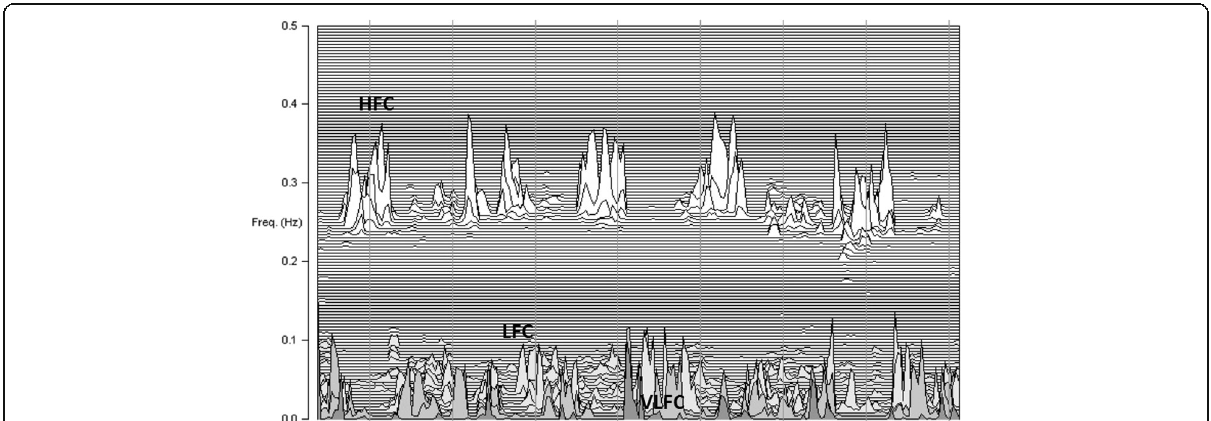
Fig. 2 Sample ECG-spectrogram. Note high, low and very low frequency coupling (HFC, LFC and VLFC respectively) and the clear separation in signal space of HFC from LFC/VLFC. HFC is the ECG-spectrogram signal biomarker of stable breathing and stable sleep. VLFC reflects REM or wake